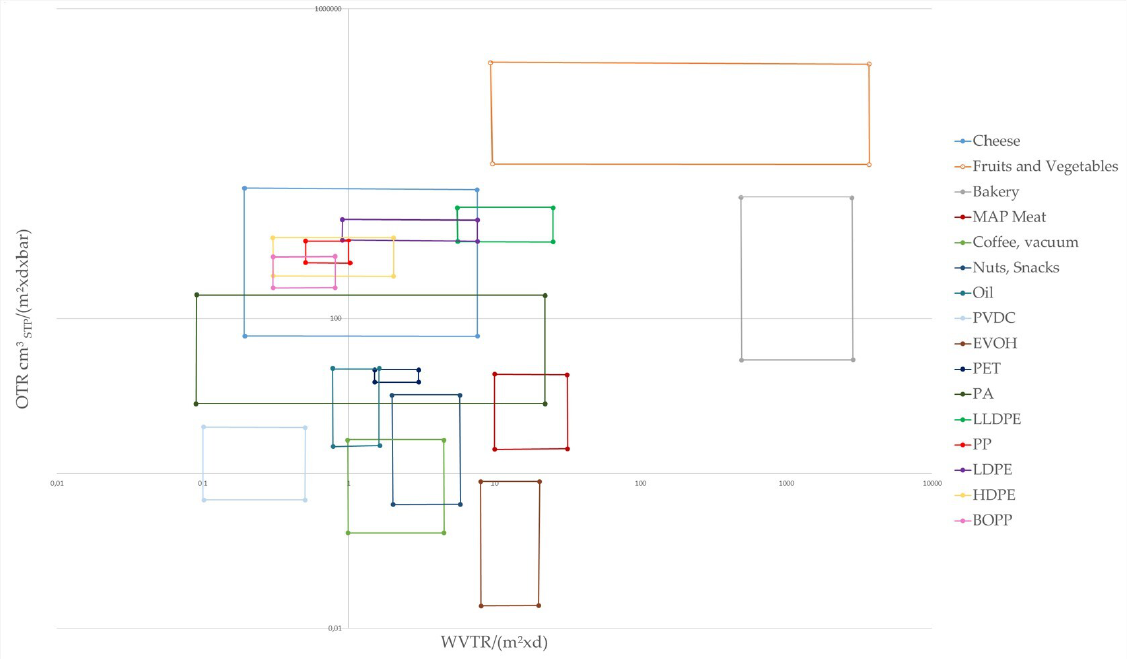
Figure 3. Water vapor and oxygen transmission rates versus the barrier requirements of food products and barrier ranges of polymers for packaging. Modified after the work in